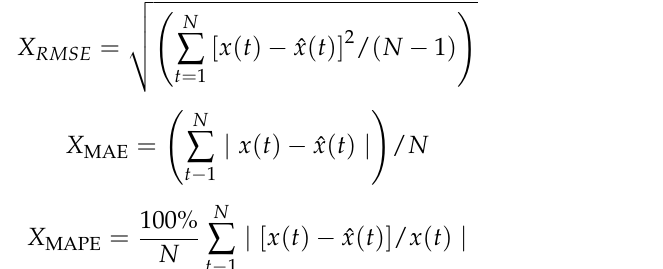
Table 1. Fault location performance of different models.